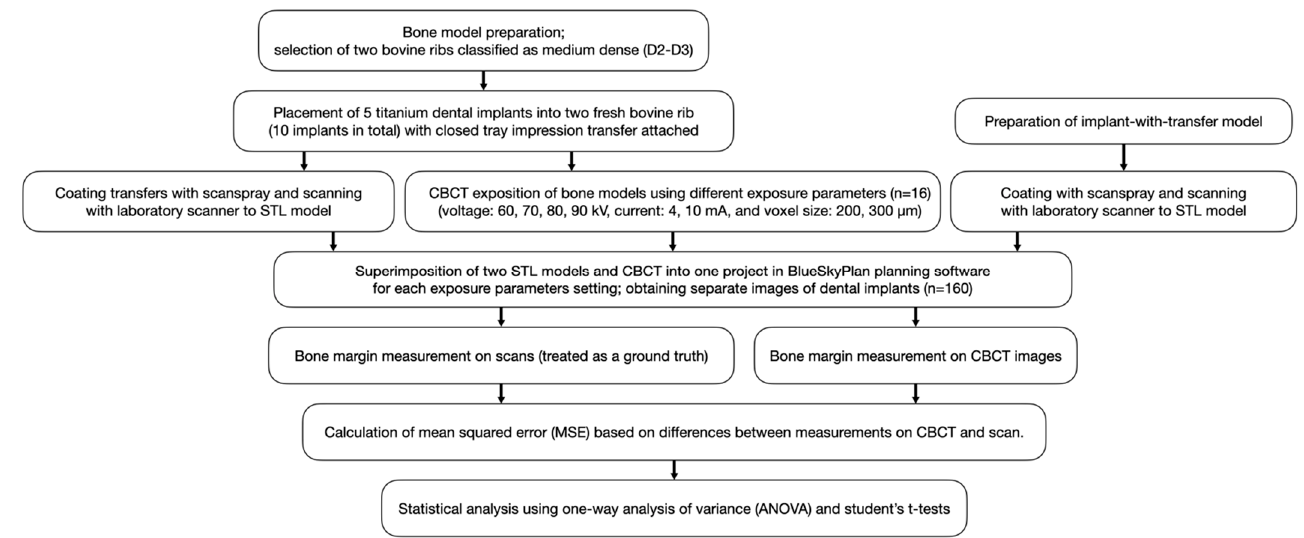
Figure 4. Study design flowchart.